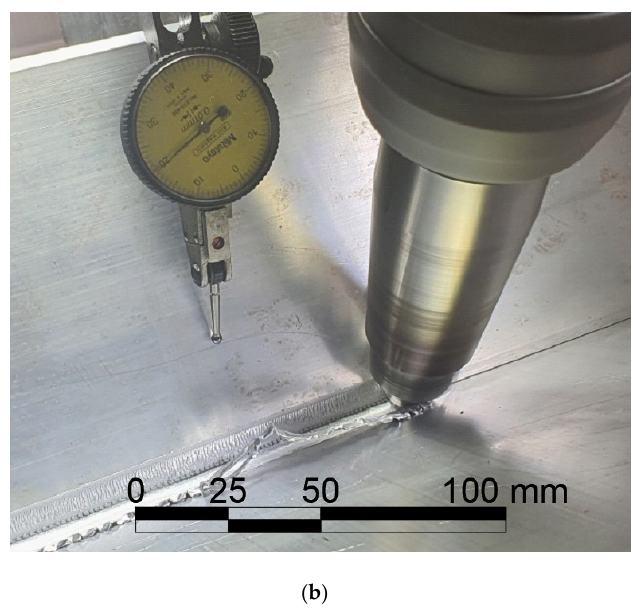
Figure 21. FSW deformation: ( a ) Deformation history result; ( b ) deformation measured during welding.